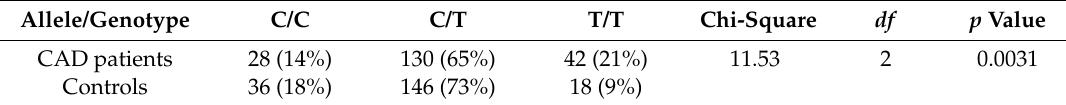
Table 5. Genotype frequency of LDLR rs688C > T polymorphism of study